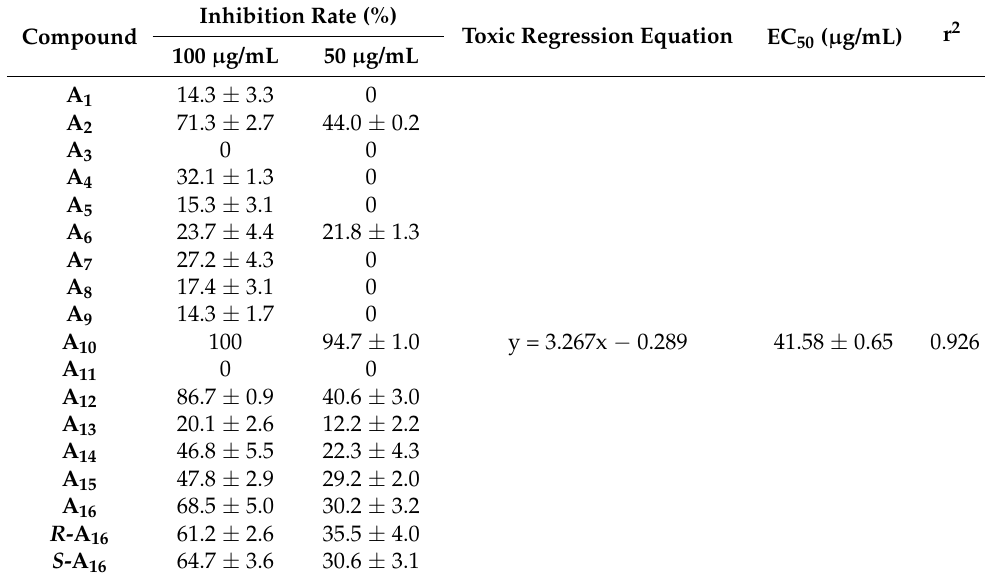
Table 7. The in vitro antibacterial activities of target compounds against plant pathogen Xac